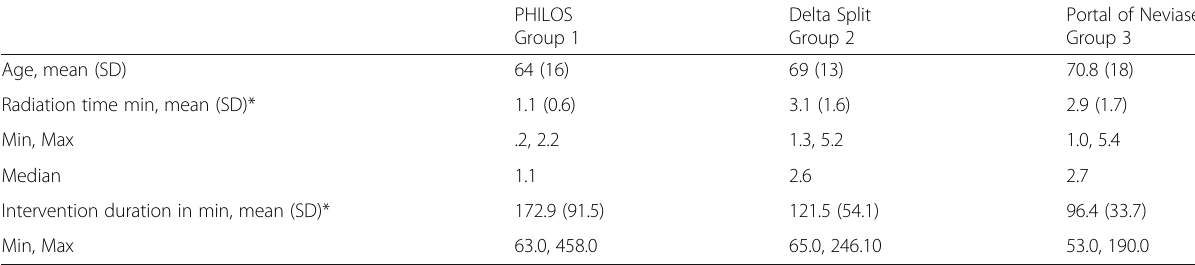
Table 1 Length of radiation and length of surgery in the different groups. * p -value < 0.01